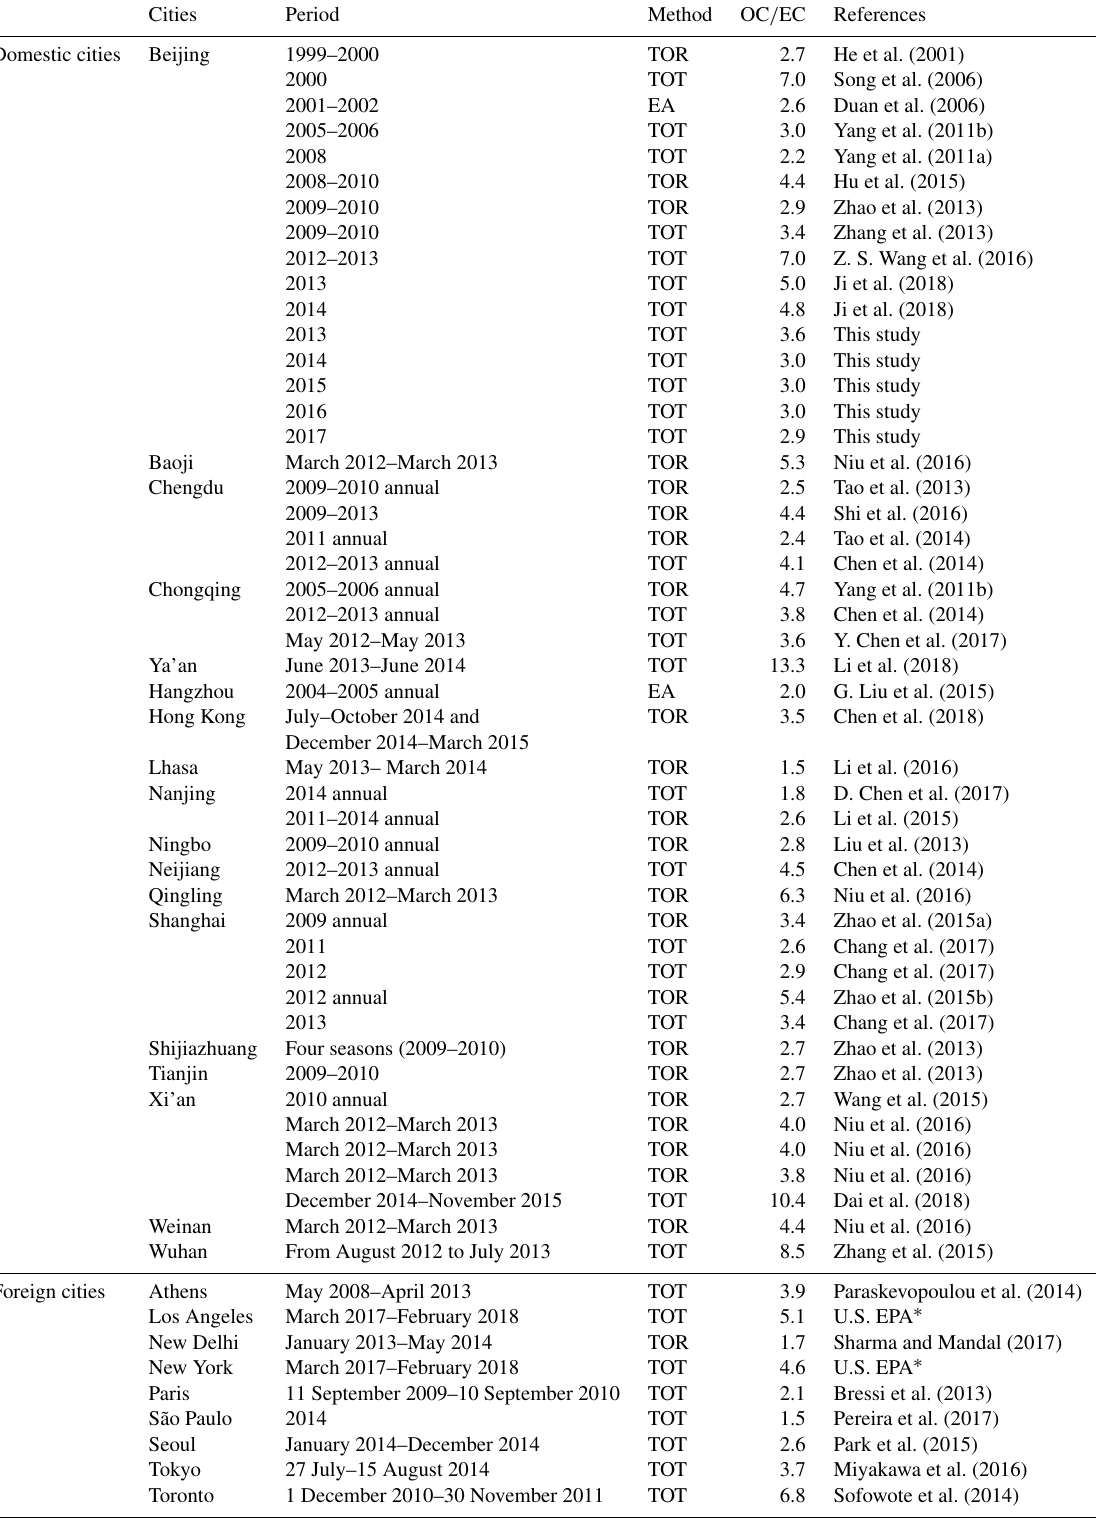
Table 3. OC / EC ratios in main domestic and foreign cities. Cities